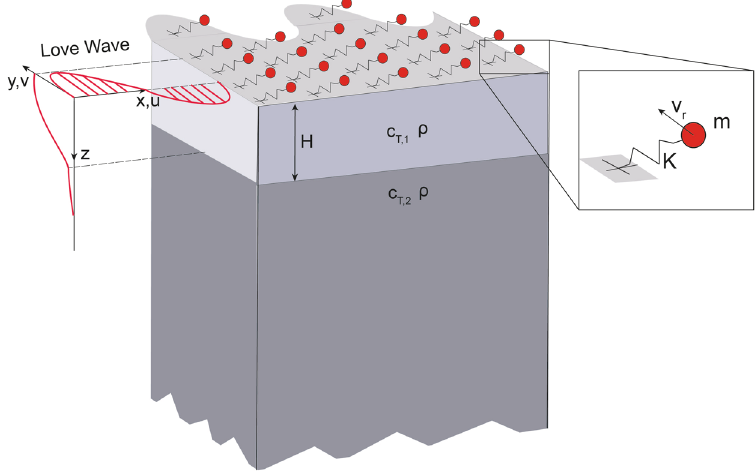
Figure 1. Schematic of Love waves interacting with an array of horizontal